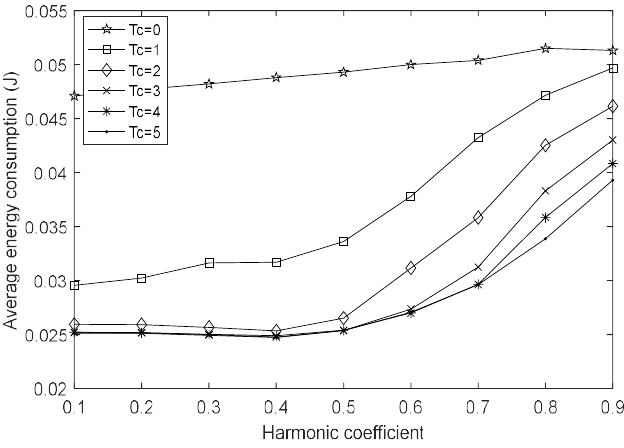
Figure 7. Average energy consumption with varying harmonic coefficient.